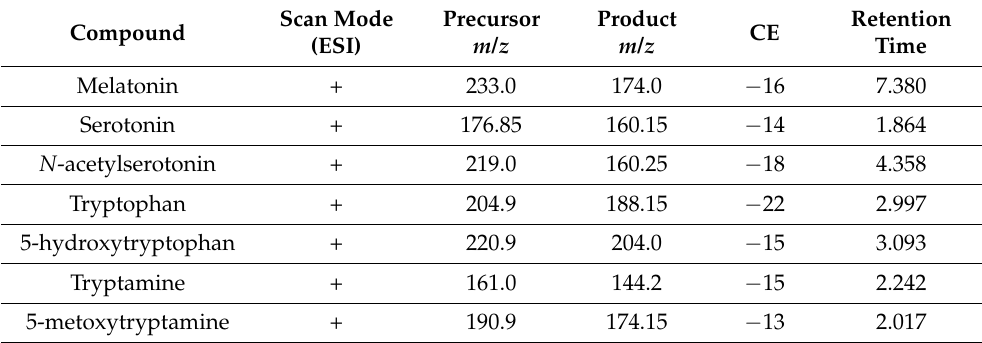
Table 4. Chromatographic properties of melatonin and its intermediates in positive ionization scan mode of